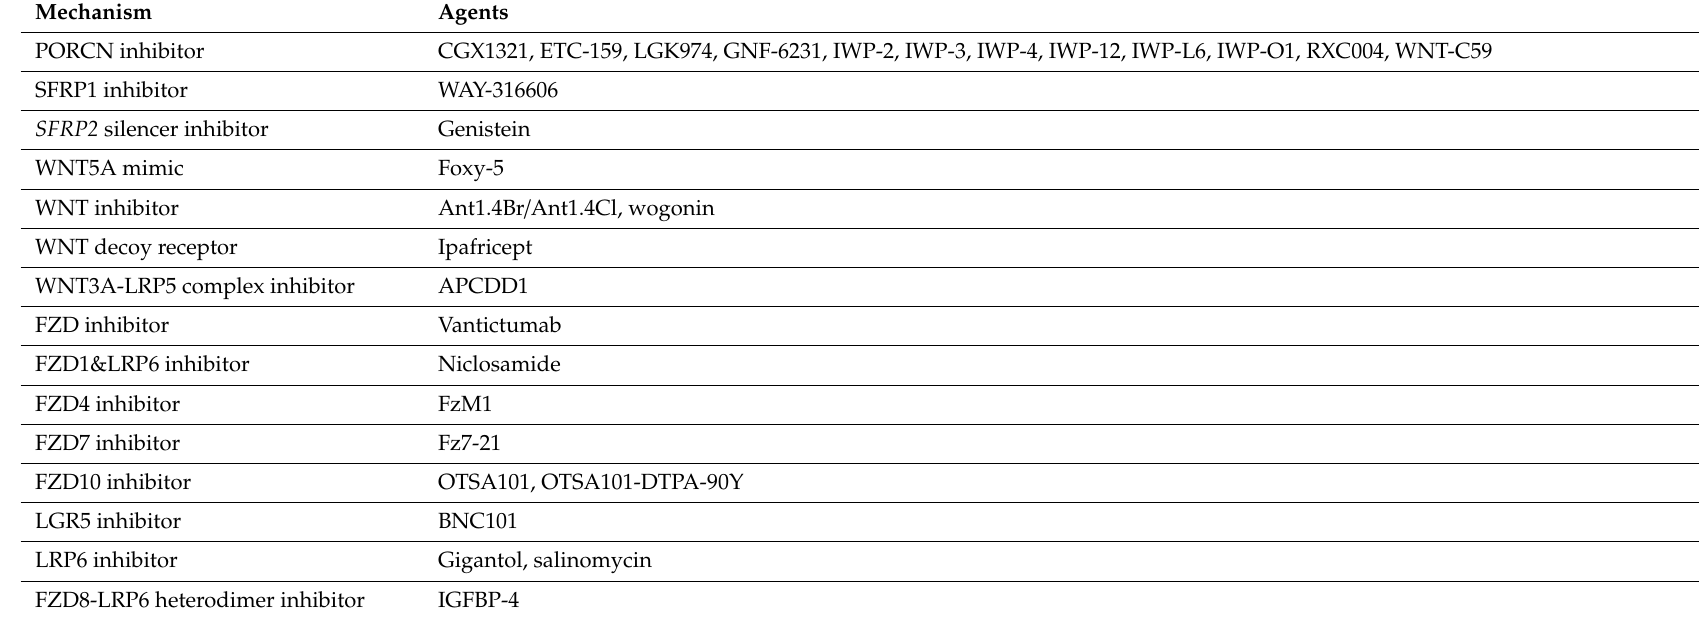
Table 3. All potential agents inhibiting Wnt